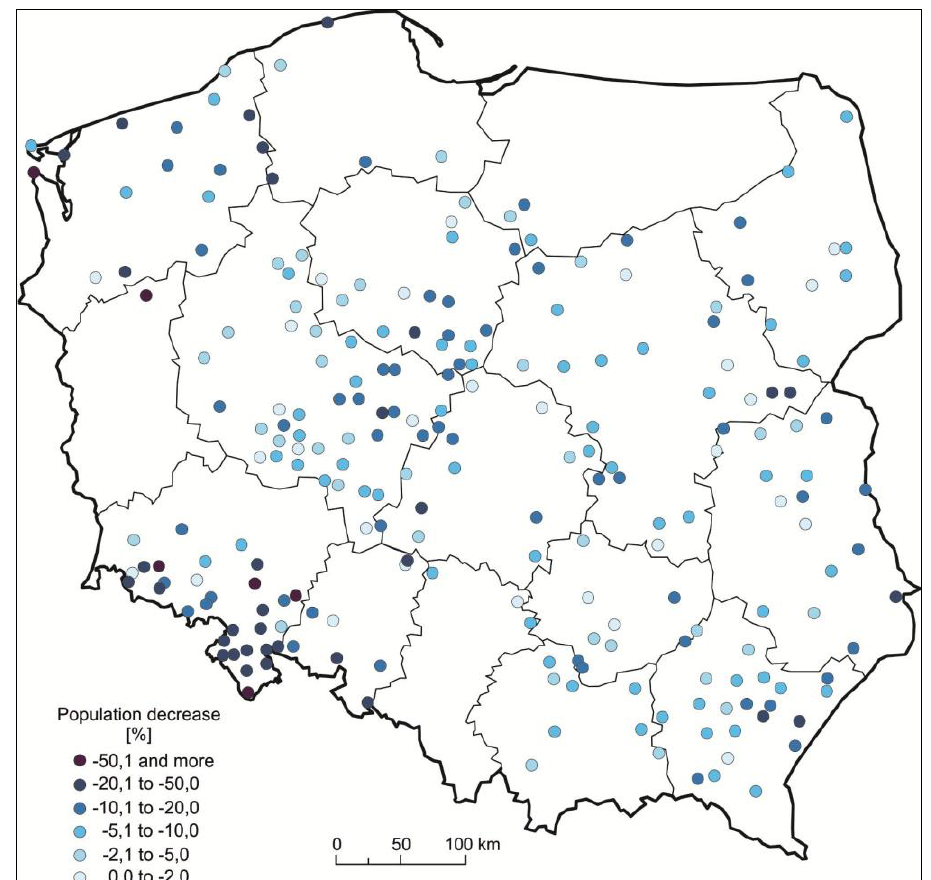
Fig. 1. Population decrease in towns of Poland, 1946-1950 (by author on the basis of Annex 2: Kantor-Pietraga,